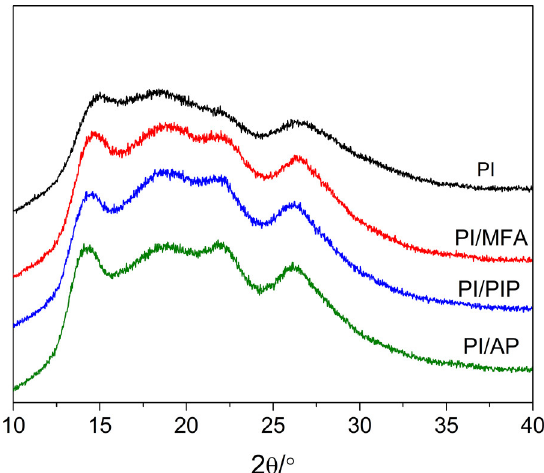
Figure 4. WAXD patterns of PI fibers and PI fibers treated by MFA, PIP and AP.